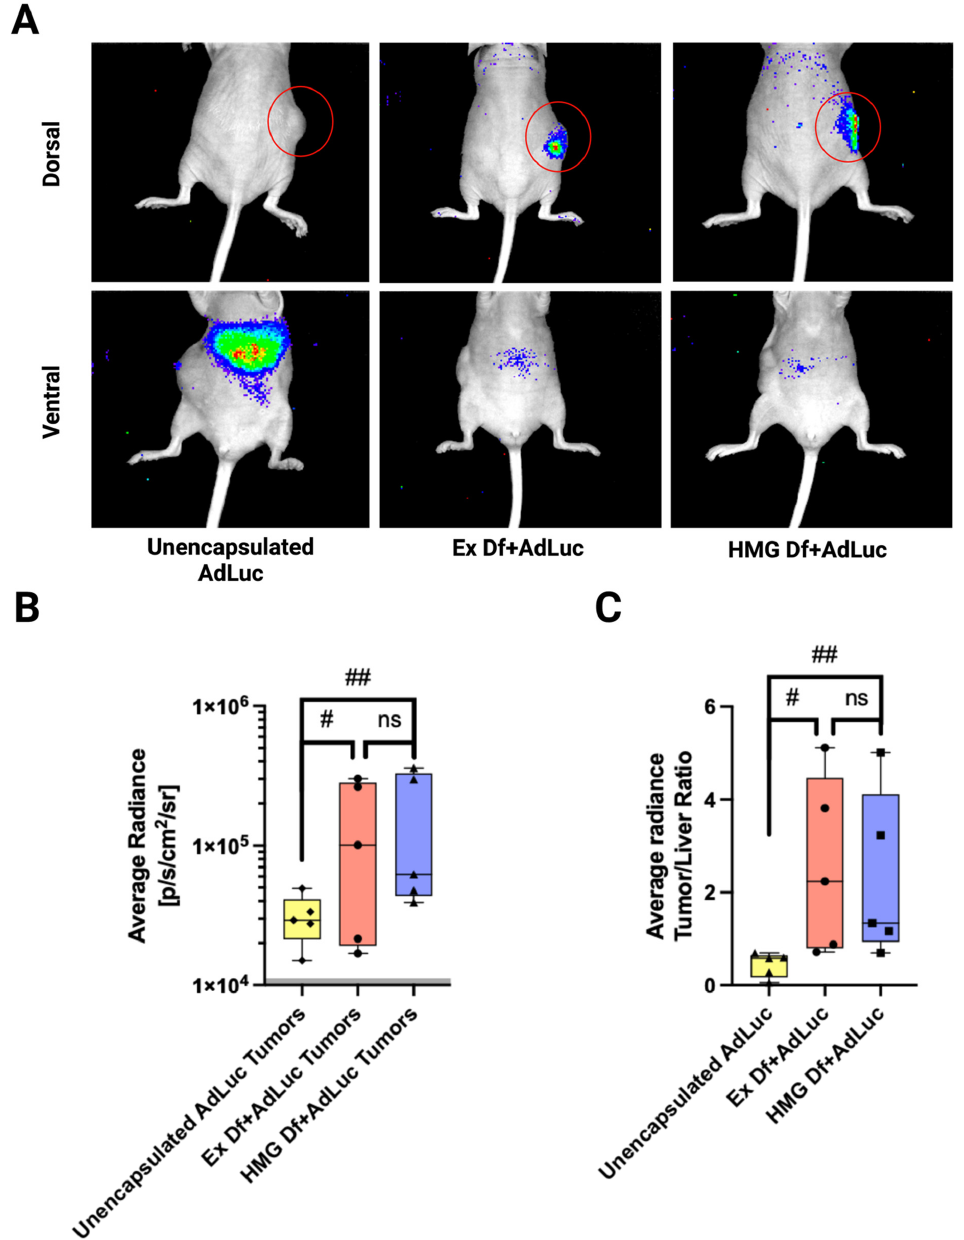
Figure 8. Comparative in vivo biodistribution of Ad liposomes manufactured by extrusion and homogenization techniques: ( A ) The most representative IVIS images of mice IT injected with unen- capsulated AdLuc (n = 5), Ex Df + AdLuc (n = 5), and HMG Df + AdLuc (n = 5) at 1.4 × 10 8 PFU. Both dorsal and ventral sides of each mouse were imaged after 5 days. Red circles highlight injected tumors. ( B ) Average radiance of tumors for Ex Df + AdLuc (n = 5) (red box), HMG Df + AdLuc (n = 5) (blue box), and unencapsulated AdLuc (n = 5) (yellow box) injected mice revealed enhanced transduction of tumors with both Ex Df + AdLuc and HMG Df + AdLuc. Performance of Ex Df + AdLuc, and HMG Df + AdLuc was similar ( p value: ns = not significant). Radiance < 10,000 p/s/cm 2 /sr (shaded re- gion) is considered background radiance ( p value: ns = not significant, # = 0.1204 ## = 0.1345). ( C ) For each mouse the ratio of total tumor signal to liver signal demonstrated that Ex Df + AdLuc (red box) and HMG Df + AdLuc (blue box) reduced off-tumor transduction by approximately 4-folds compared to the unencapsulated AdLuc (yellow box) ( p value: ns = not significant, # = 0.0533 ## =